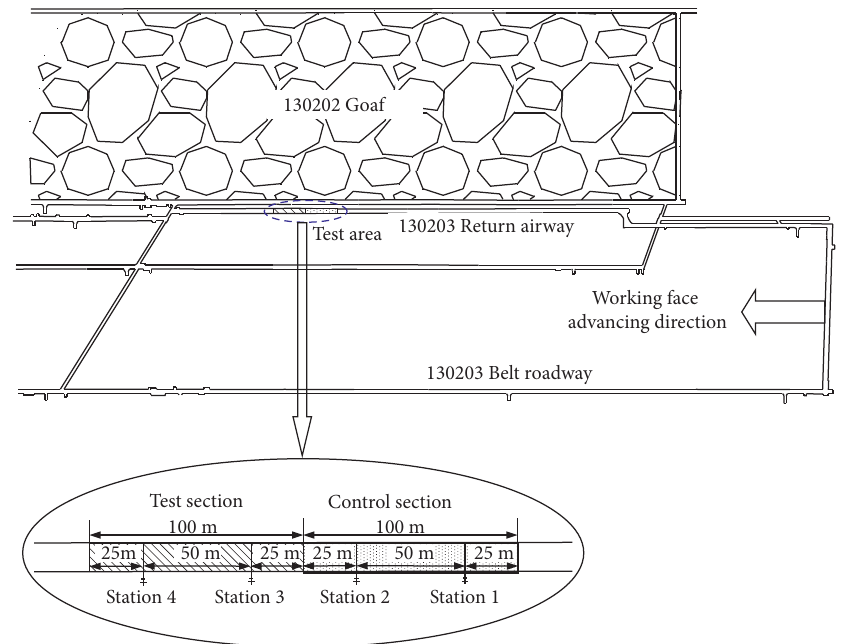
Figure 10: Test area and station layout